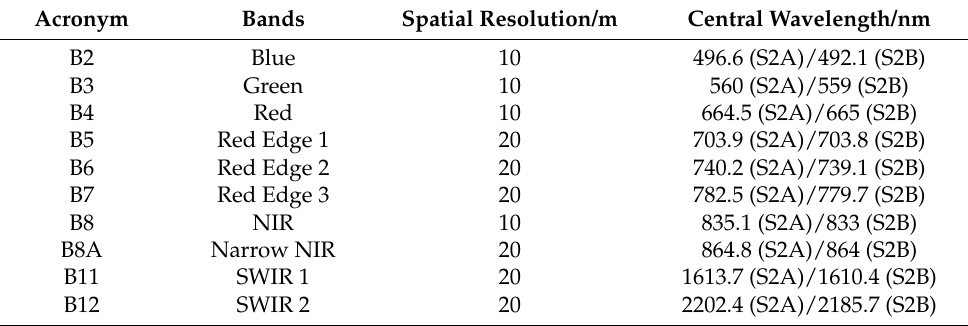
Table A1. Spectral bands of Sentinel-2 MSI sensor for saline cropland